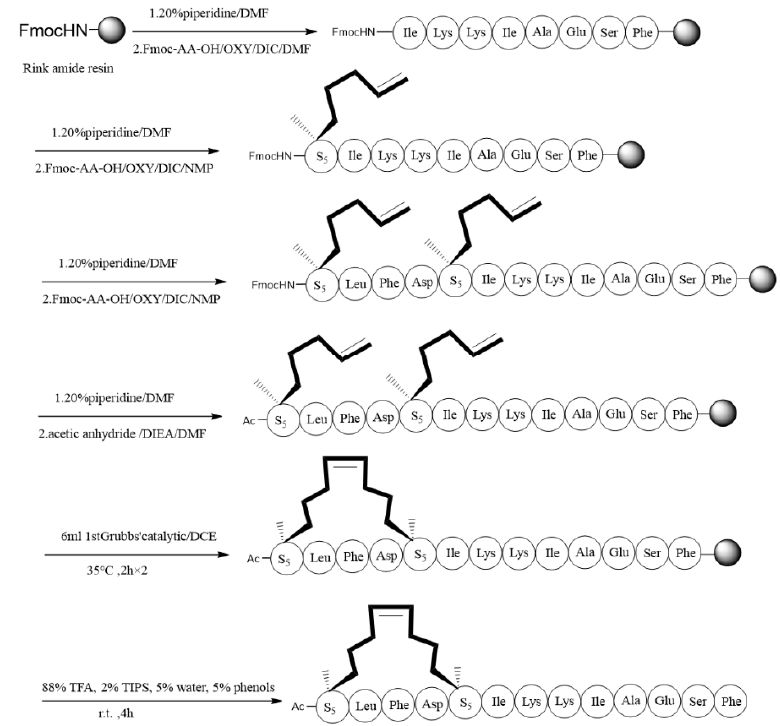
Figure 2. The synthetic route of stapled peptide Sau-1.